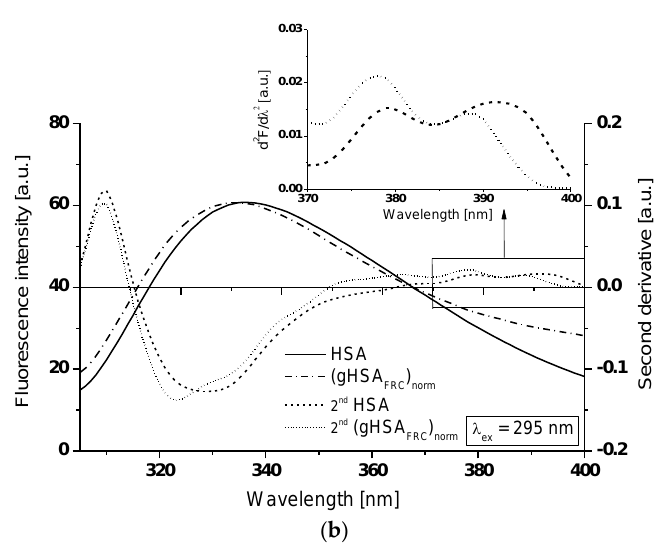
Figure 6. Main view: glycated albumin emission spectra normalized to non-glycated (gHSA FRC ) norm and second derivative fluorescence spectra of HSA and (gHSA FRC ) norm (2nd HSA, 2nd (gHSA FRC ) norm ) for ( a ) λ ex = 275 nm and ( b ) λ ex = 295 nm. Insert: tryptophan (Trp-214) region. The spectra were normalized to their respective maxima: λ em = 331 nm (λ ex = 275 nm) and λ em = 336 nm (λ ex = 295 nm); t = 37 °C.